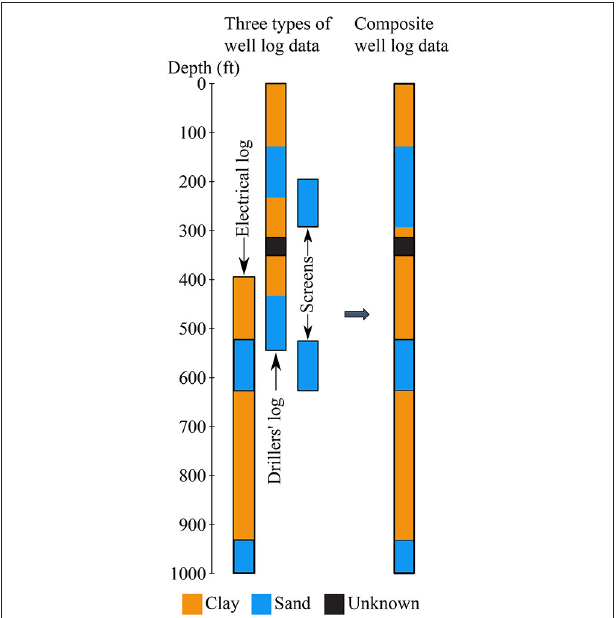
FIGURE 3 | Integration of different well log